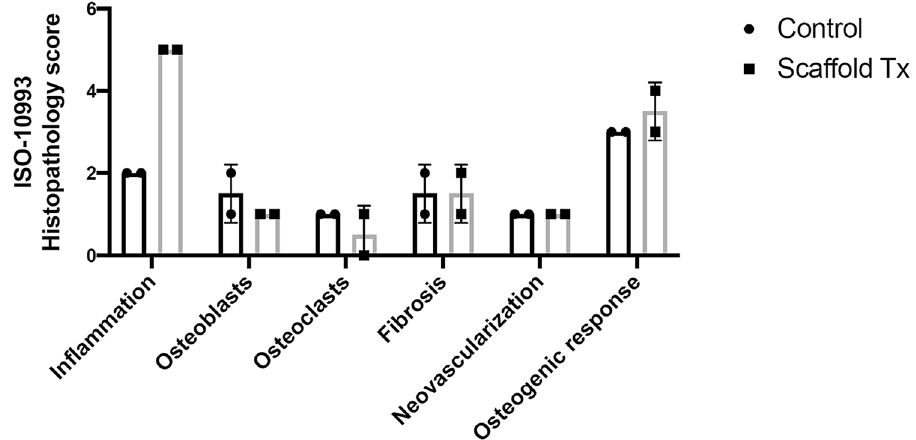
Figure 5. Mean histopathology scores of control and scaffold-treated groups for the selected histological features shown in Fig. 4. Figure was created with GraphPad Prism (version 9.0.1, https:// www. graph pad. com/ scien tific- softw are/